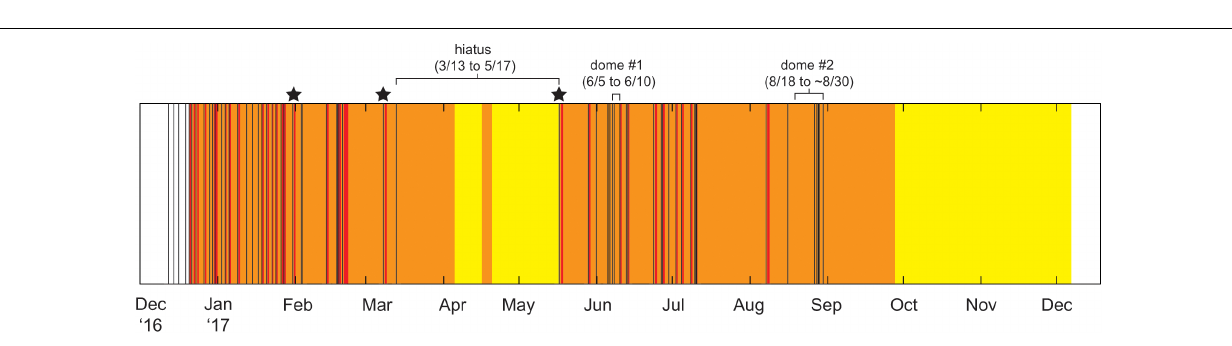
FIGURE 1 | Map of Alaska’s Aleutian volcanic arc, showing historically active volcanoes as yellow triangles and notable communities as white circles. The inset map shows Bogoslof Island and nearby islands with volcano-monitoring equipment used in this study.